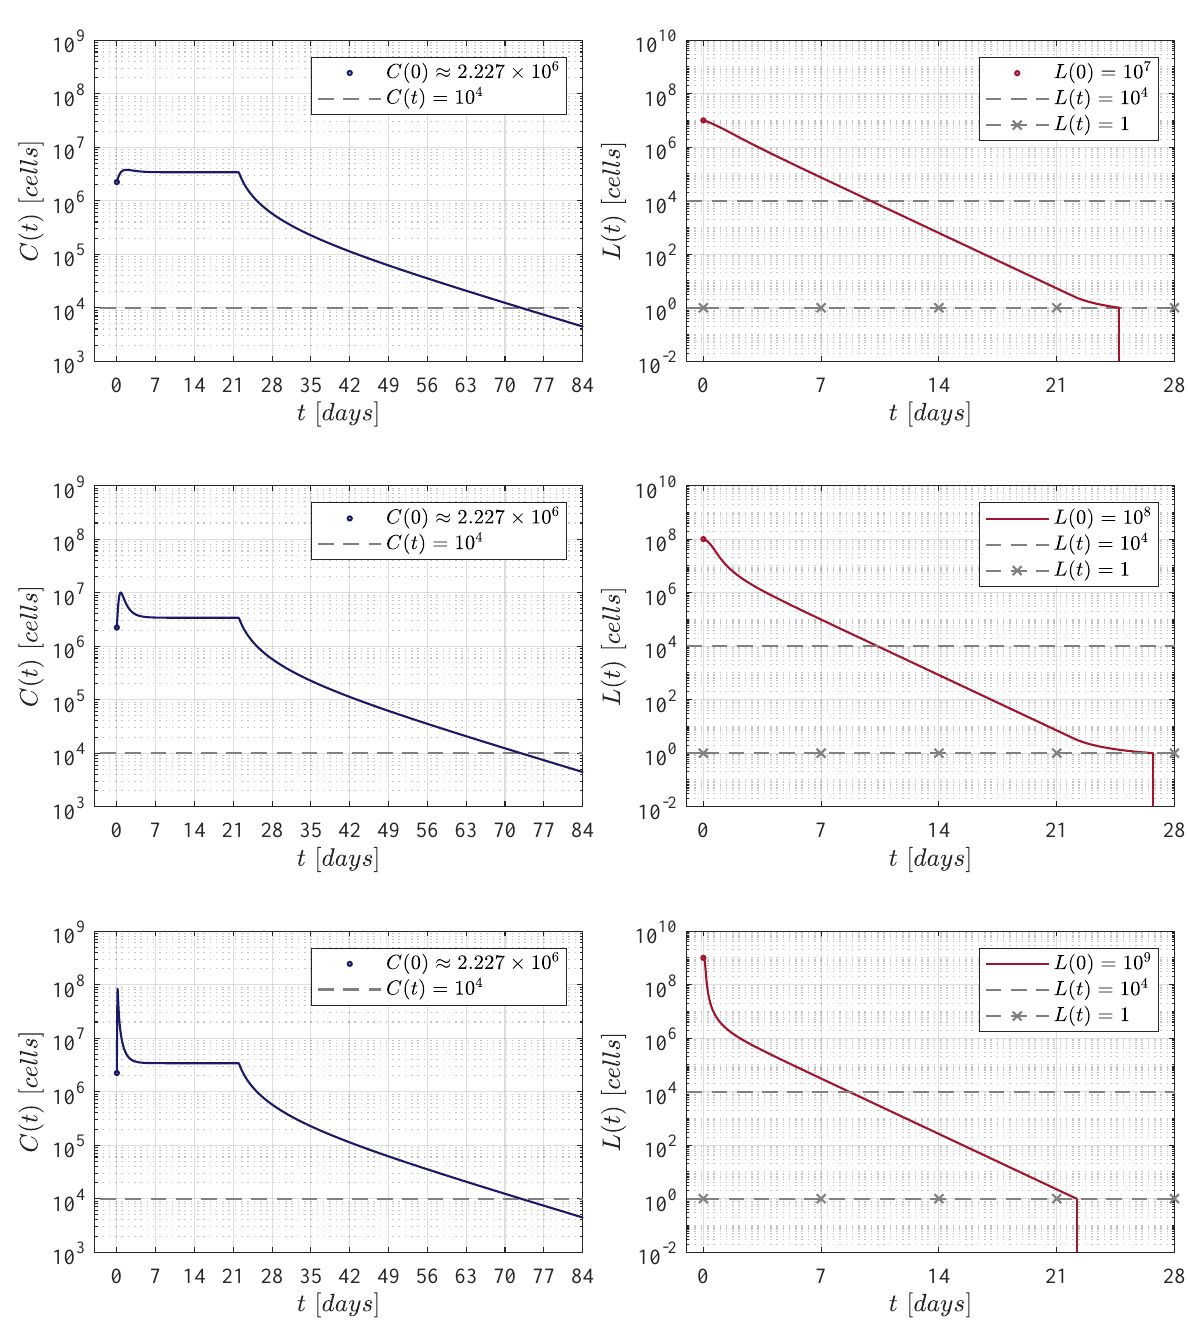
Figure 5. The daily administration protocol. In this case we aim for CR by day 28 by means of daily therapy applications from day 0 to day 21 as it was the last day of application in the weekly protocol illustrated in Figure 4. The latter allows for one week of rest between the last dose and the peripheral blood test indicated in Lee et al. [11] at day